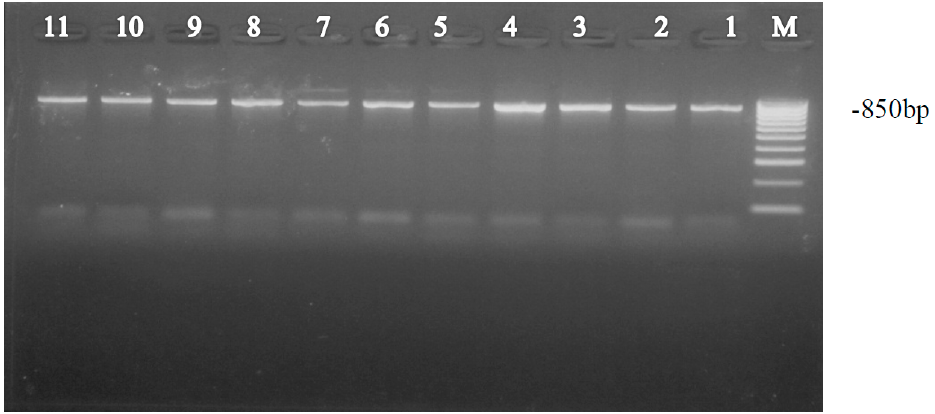
Figure 4. Polymerase chain reaction-amplified product (~850 bp) of B. tabaci . Table 2. Geographic distribution of the five distinct clades of whiteflies found in Kenya. SSA-A-E corresponds to the clades found in Figure 3.